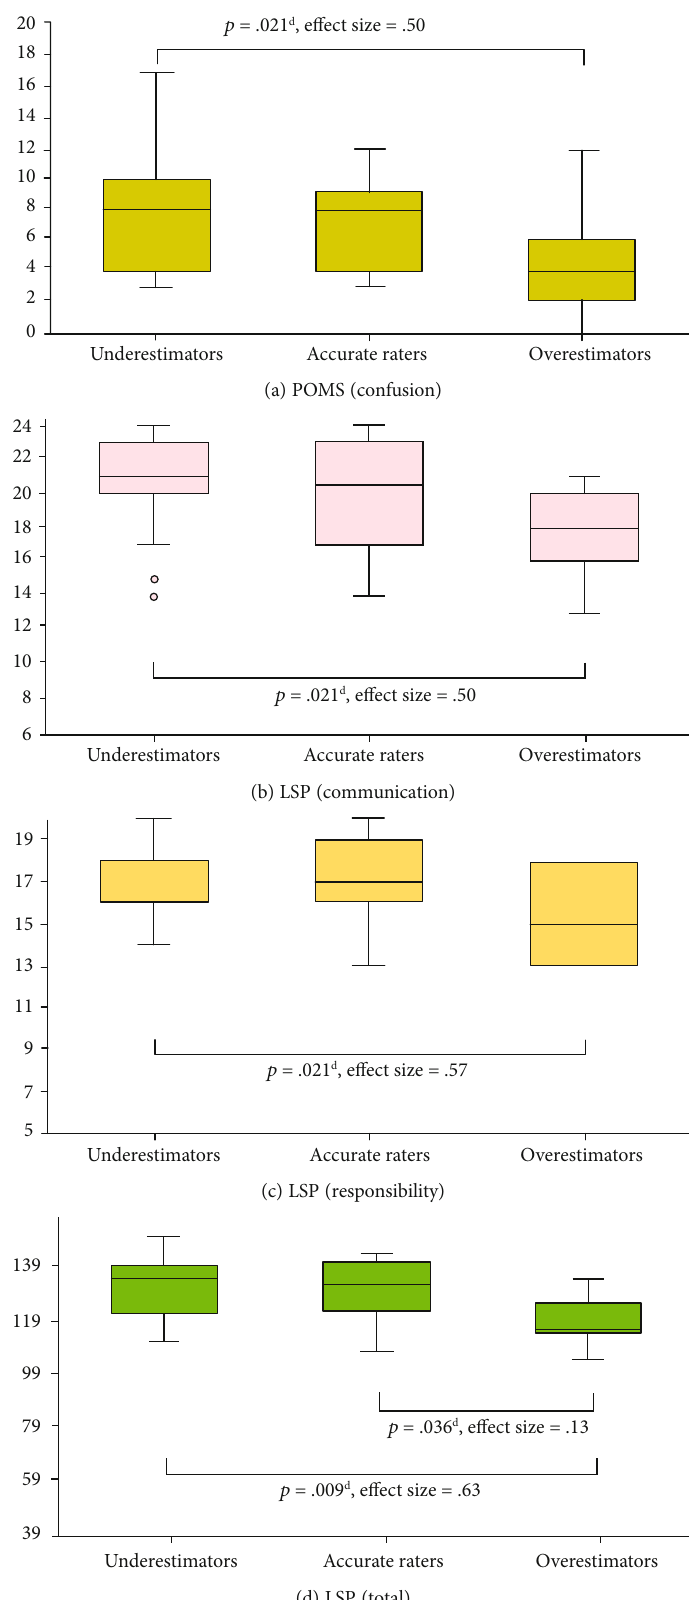
Figure 1: Items with signi fi cant di ff erences among the three groups as determined by multiple comparisons. Note. d Multiple comparisons with Bonferroni correction; POMS: Pro fi le of Mood States; LSP: Life Skills Pro fi